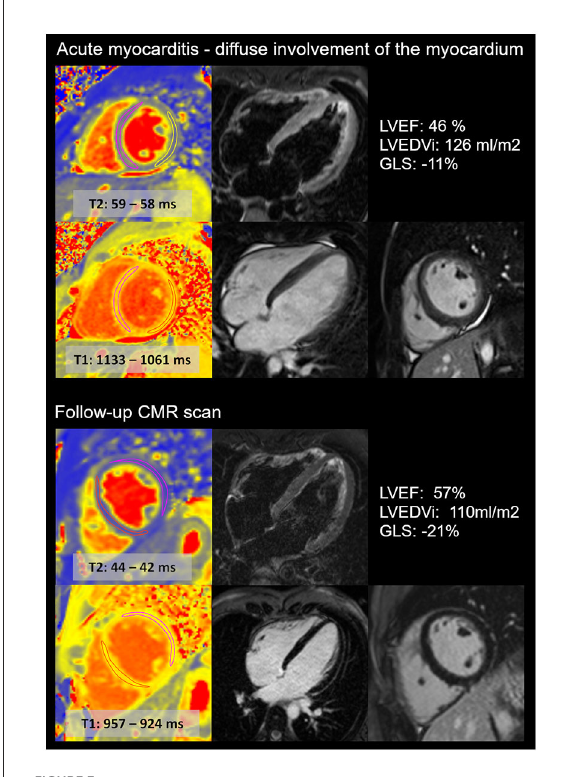
FIGURE3 Diffuse acute myocarditis after the second dose of anti-COVID-19 mRNA vaccine in a young athlete. CMR images show the acute (upper images) and follow-up (lower images) scans of a young, highly trained athlete (national team member). The first CMR scan confirmed acute myocarditis with diffuse involvement of the myocardium, with elevated T2 and T1 mapping and diffuse myocardial oedema. The left ventricular ejection fraction (LVEF) was mildly decreased, and global longitudinal (GLS) strain was decreased during the acute scan. The follow-up scan revealed the normalization of T2 and T1 mapping values and left ventricular systolic function. The LVEDVi decreased. No LGE was present. The patient was prohibited from participation in sports activity for the first 3 months, and then he gradually returned to sports activity. Currently, the athlete performs a high level of sports activity and does not report recurrent or persisting